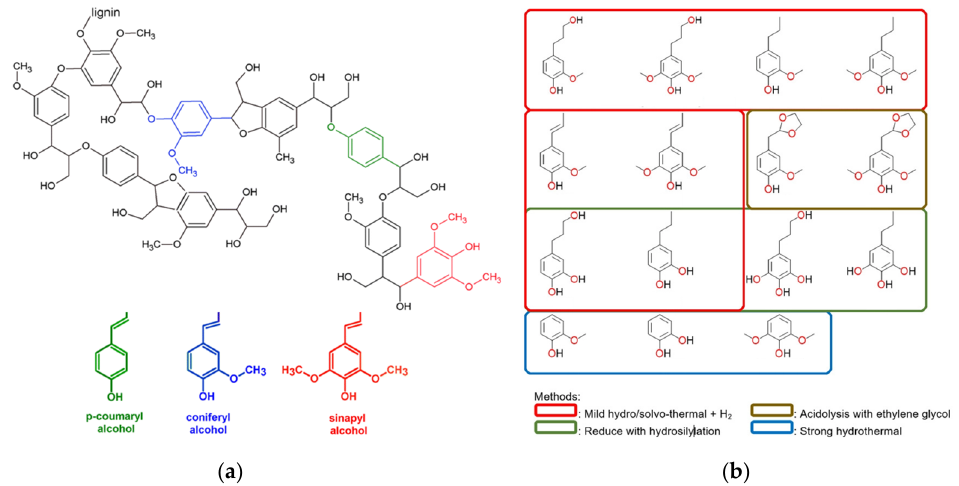
Figure 1. ( a ) Typical fragments of lignin structure with its main monolignols and ( b ) the potential phenolic products from lignin degradation. Reprinted with permission from Refs. [8,9]. Copyright 2019, Springer Nature Switzerland AG & Wiley.